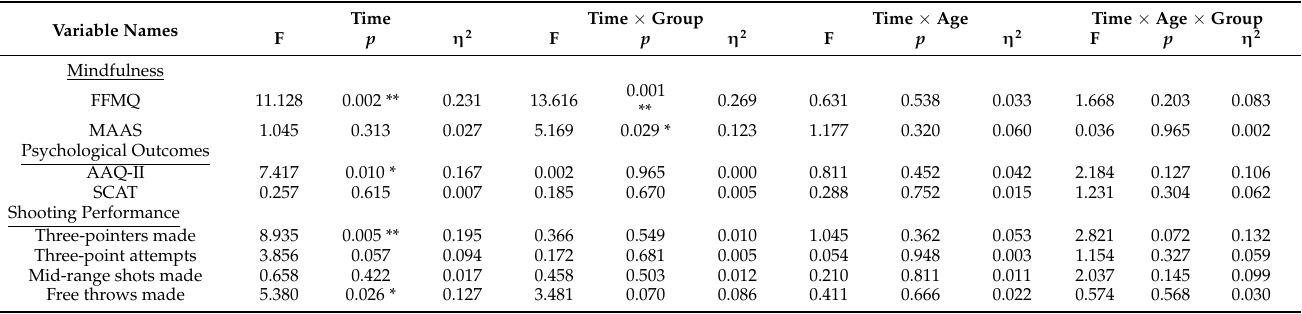
Table 5. Effect of mindfulness training on psychological skills and shooting performance with age